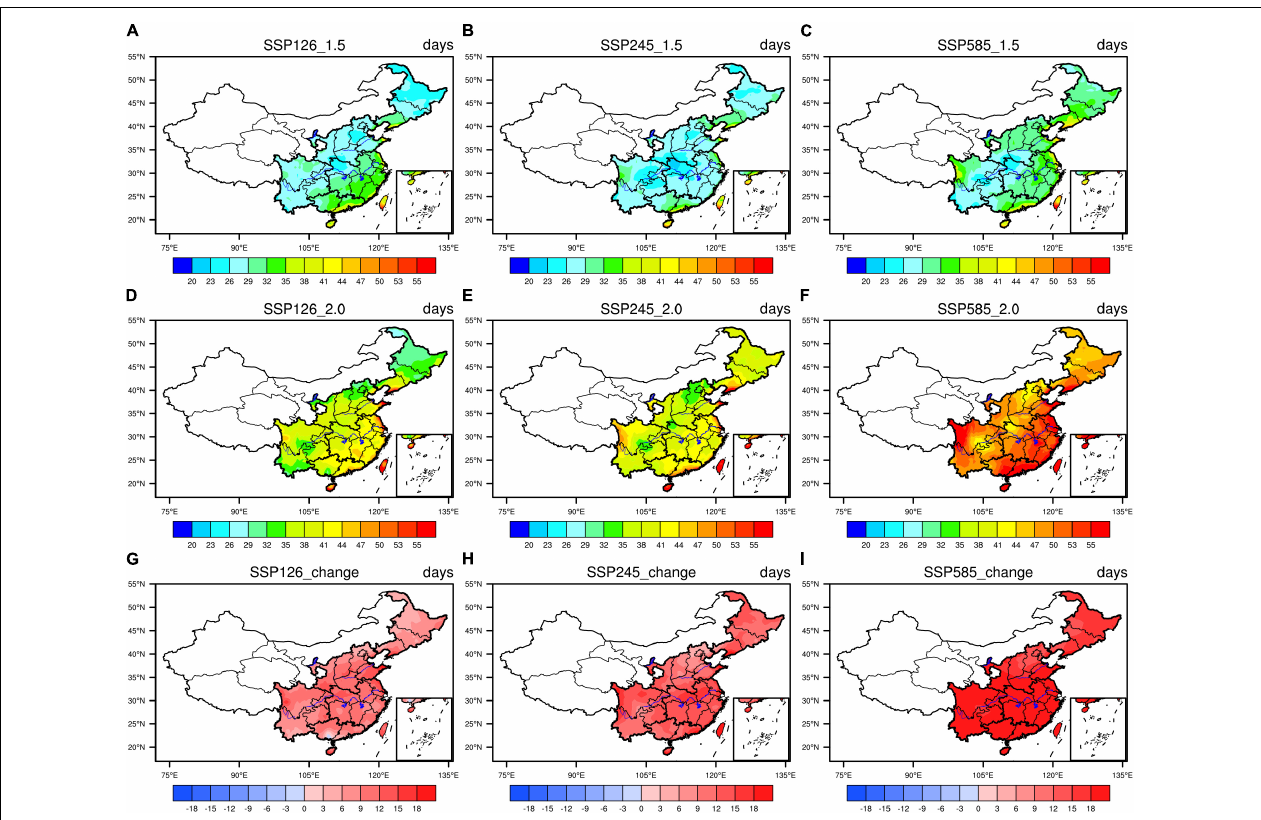
Frontiers in Earth Science |